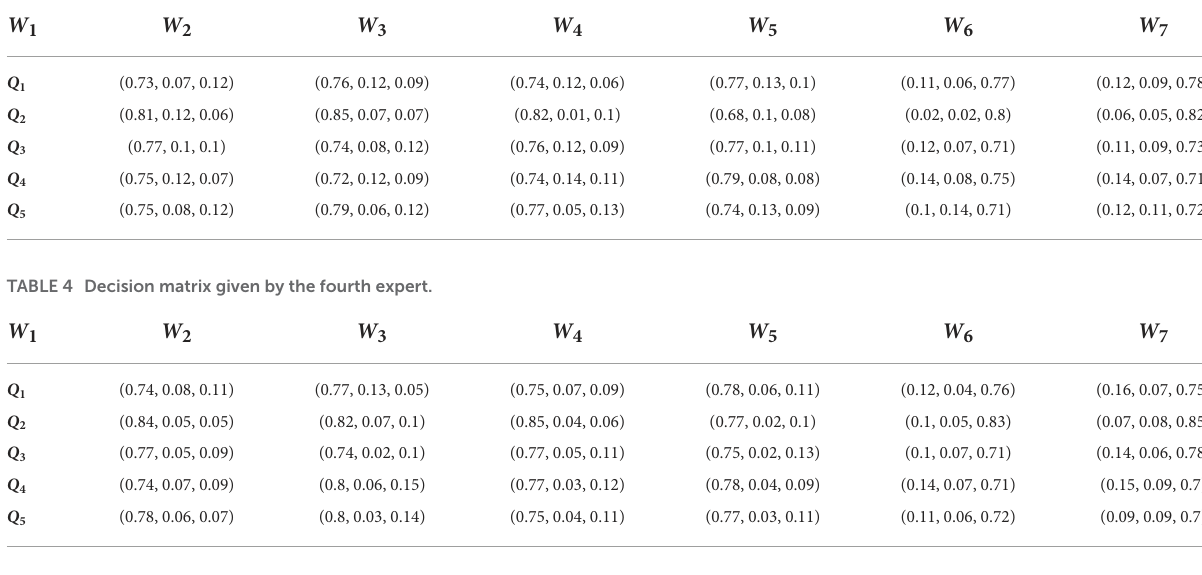
TABLE 3 Decision matrix given by the third expert E 3 .